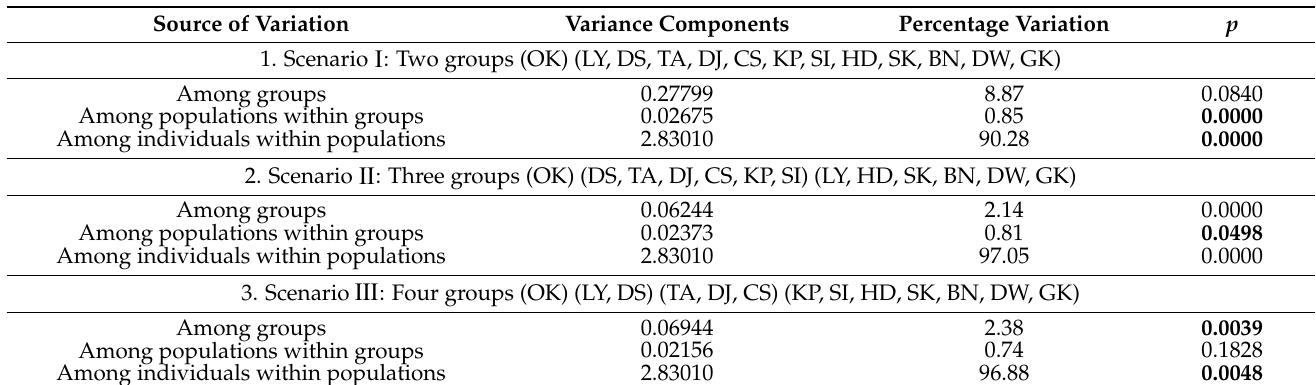
Figure 3. The median-joining network of 142 haplotypes of Macrobrachium japonicum based on par- tial mtDNA COI gene. Each circle represents a haplotype, and the circle size is proportional to the haplotype frequency. Black numbers in the bars across the branches are the number of mutational steps. Table 2. Analysis of molecular variance (AMOVA) for Macrobrachium japonicum populations in three scenarios based on partial mtDNA COI gene.